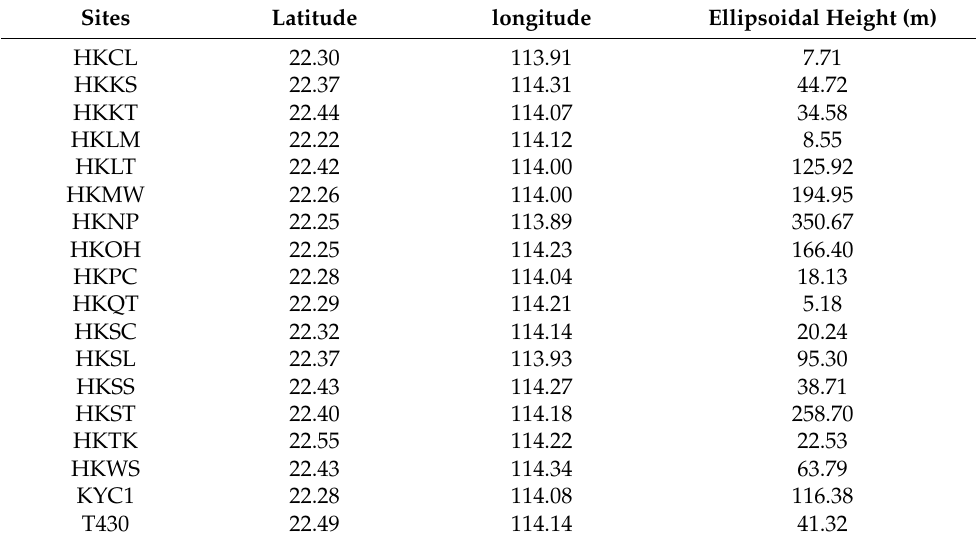
Table 1. The coordinates of GNSS stations in Hong Kong.